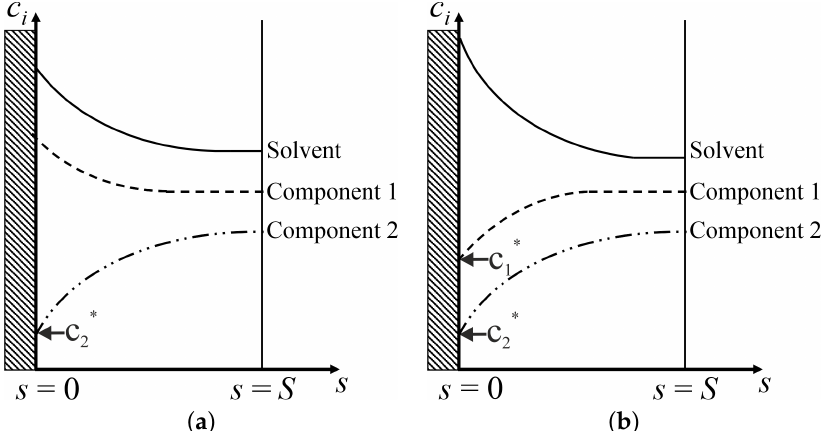
Figure 1. Diagram ( a ) represents concentration evolution in a slab of a solution of two components dissolved in a solvent. The special case of only one component (component 2) crystallizing while both other components do not crystallize is shown. The two non-crystallizing components level-up in the liquid phase. In Diagram ( b ), simultaneous crystallization of components 1 and 2 is depicted. Again, at the solid-liquid interface concentrations are set to equilibrium. Here, only the solvent enriches in the vicinity of the